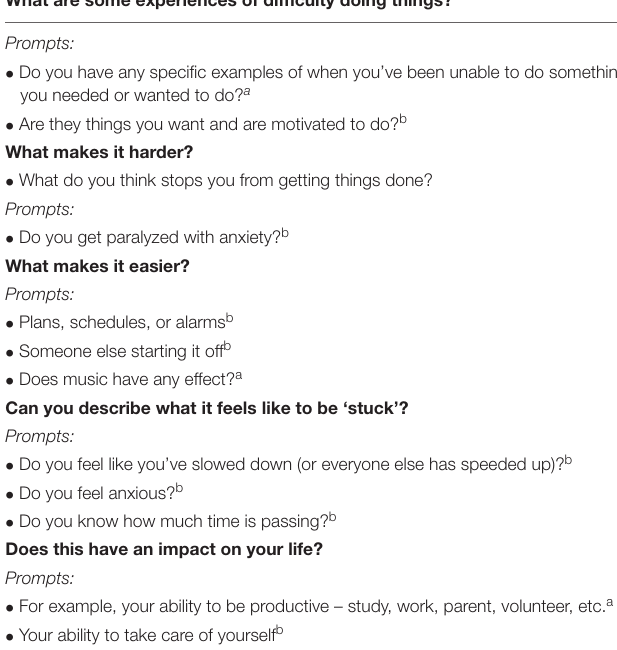
TABLE 2 | Focus group questions and